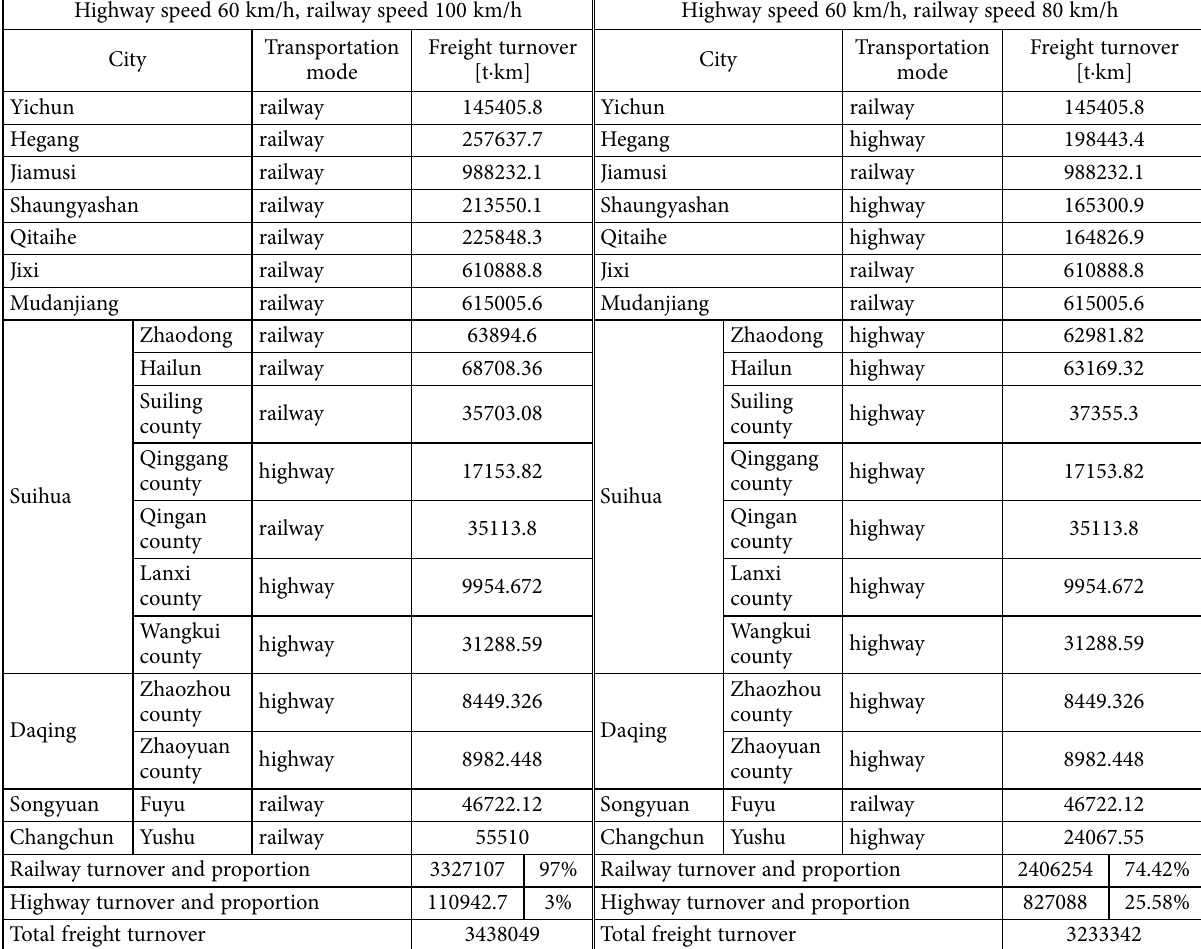
Table 8. Freight turnover and proportion at different speed